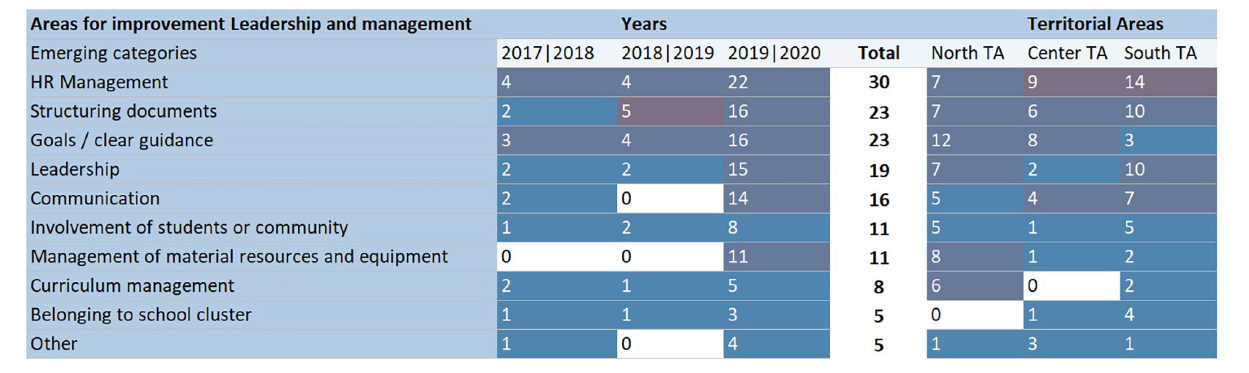
FIGURE 6 | Leadership and management: areas for improvement. The distribution of coded segments by subcategories, year, and